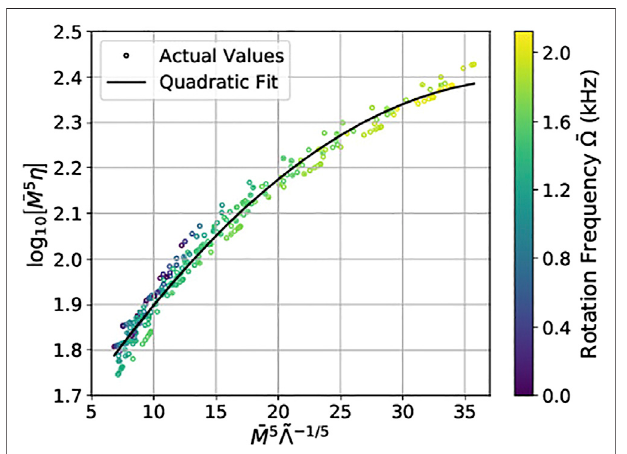
FIGURE 5| The quadratic fi tbetween (cid:2) M 5 ~ Λ − 1/5 and (cid:2) M 5 C for q (cid:1) 1. The fi t corresponds to Eq. 15 . Figure taken from Manoharan et al. (2021) with permission by APS.